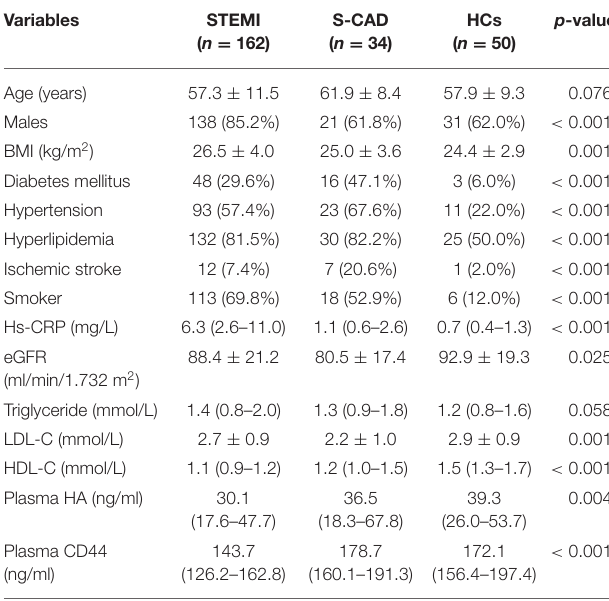
healthy controls. Variables STEMI ( n = 162)